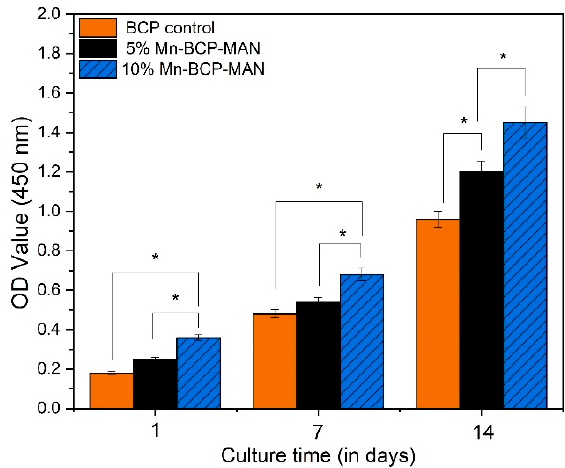
Figure 8. MTT assay of MG63 cells on the scaffolds; * denotes p < 0.05.